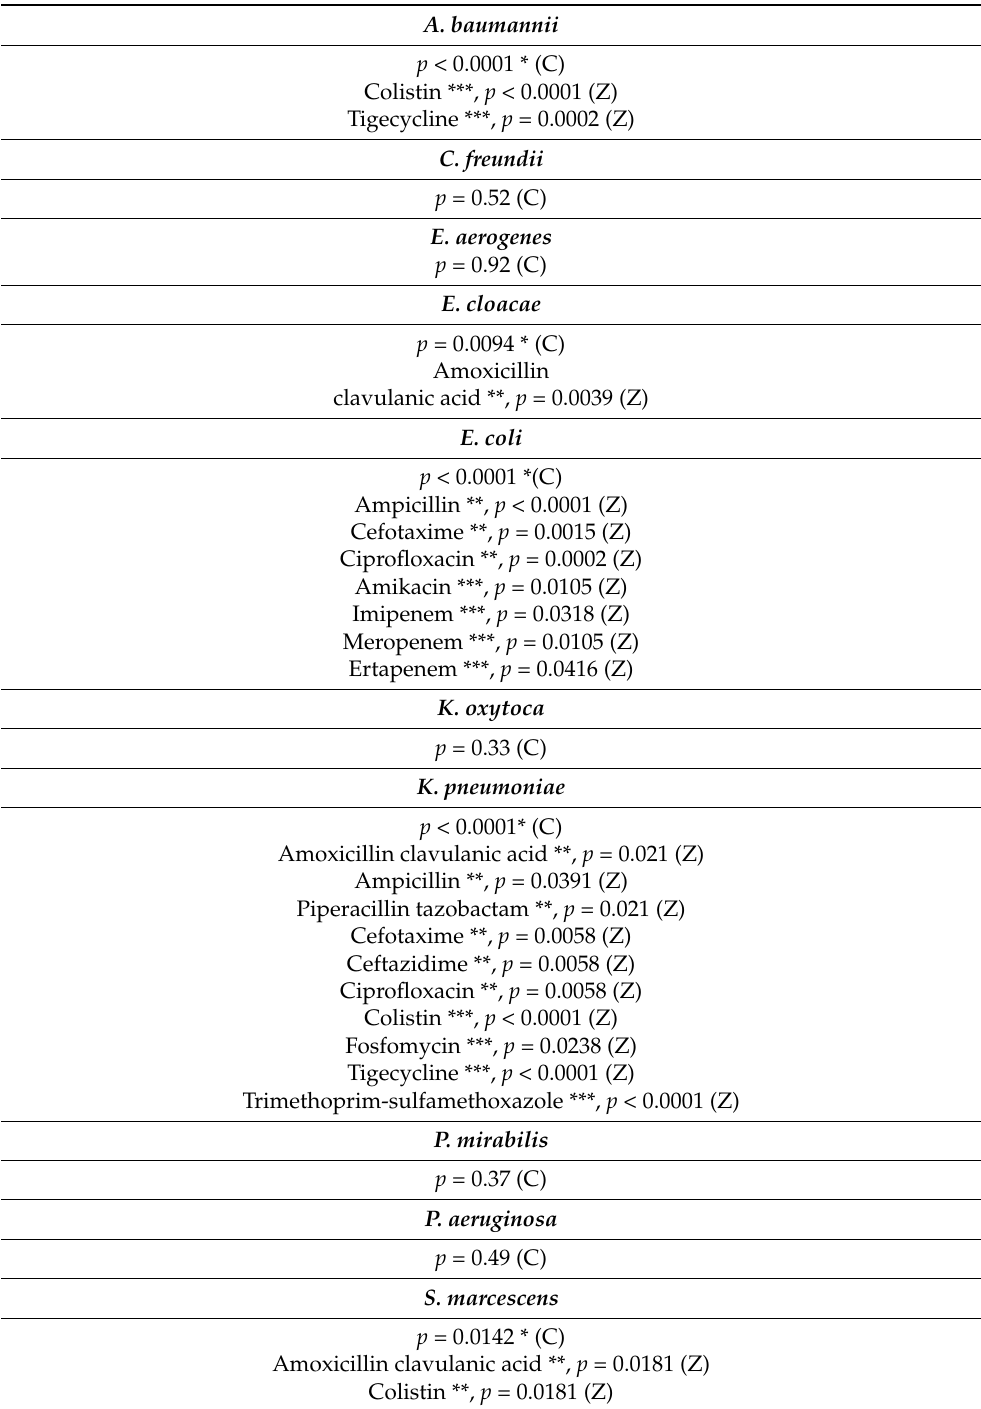
Table 5. Resistance and susceptibility of 105 Gram-negative